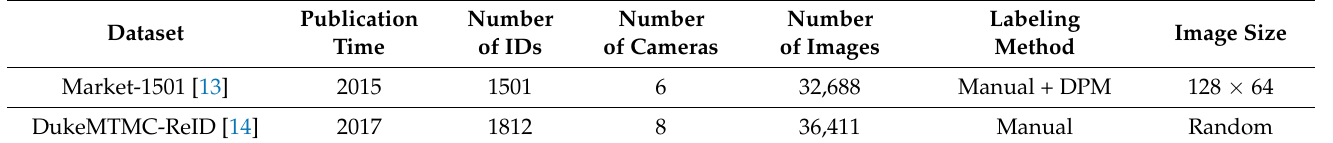
Table 1. The details of person Re-ID datasets (Market-1501 and DukeMTMC-ReID).